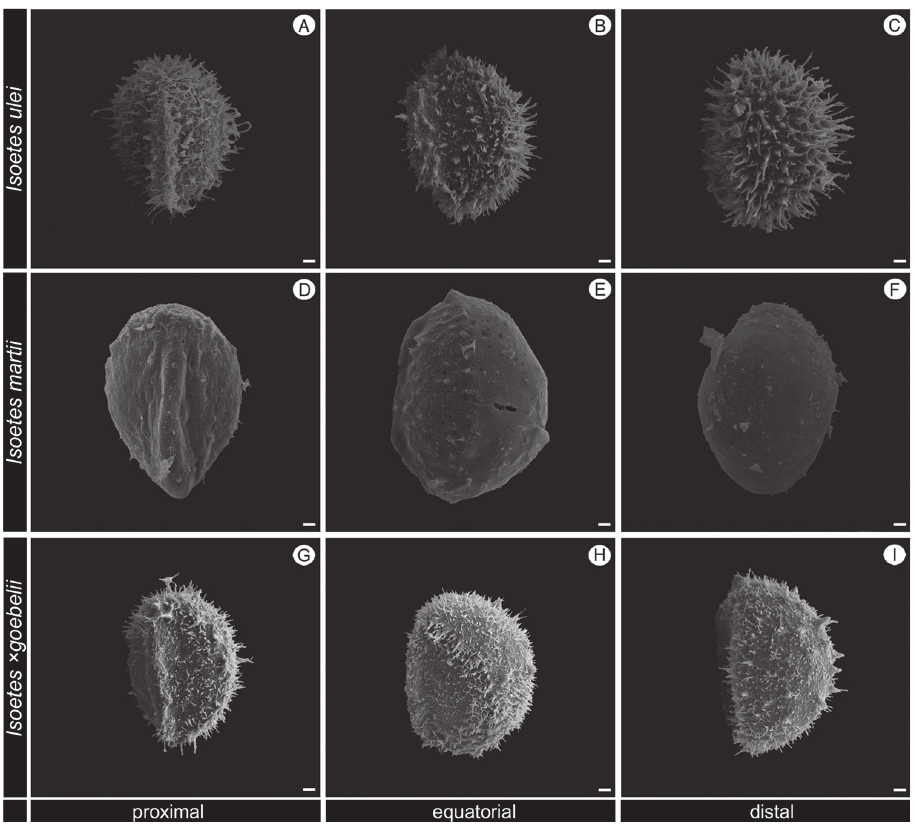
Figure 5. SEM images of the microspore of Isoetes ulei (Ule 3533, HBG), I. martii (Regnel 1505, B) and I. ×goebelii (Pereira 718, UPCB). A–C Microspore of I. ulei A Proximal view B Distal view C Equatorial view D–F Microspore of I. martii D Proximal view E Equatorial view F Distal view G–I Microspore of I. ×goebelii G Proximal view H Equatorial view I Equatorial view. All scale bars = 2 µm However, based on our current knowledge on this species and according to IUCN Red List criteria (IUCN 2012), it is assessed here as data deficient